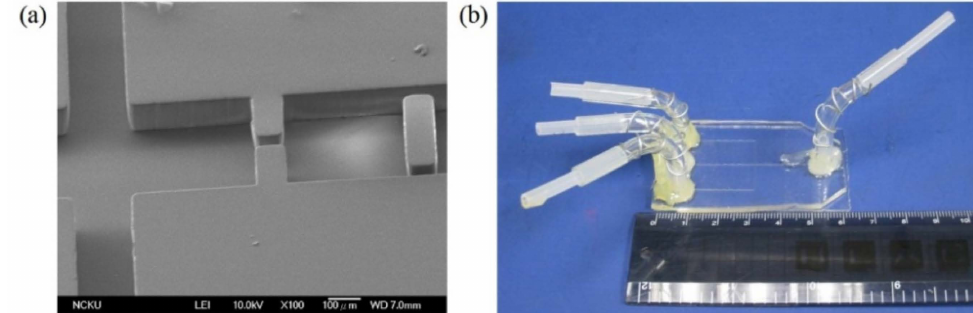
Figure 24. ( a ) SEM image of the PDMS replica layer with gap ratio of 1/8. ( b ) An obstacled micromixer with three inlets and one